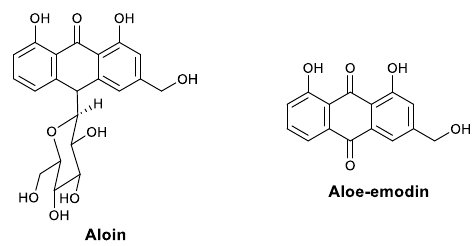
Figure 6. Structures of aloin and aloe-emodin.